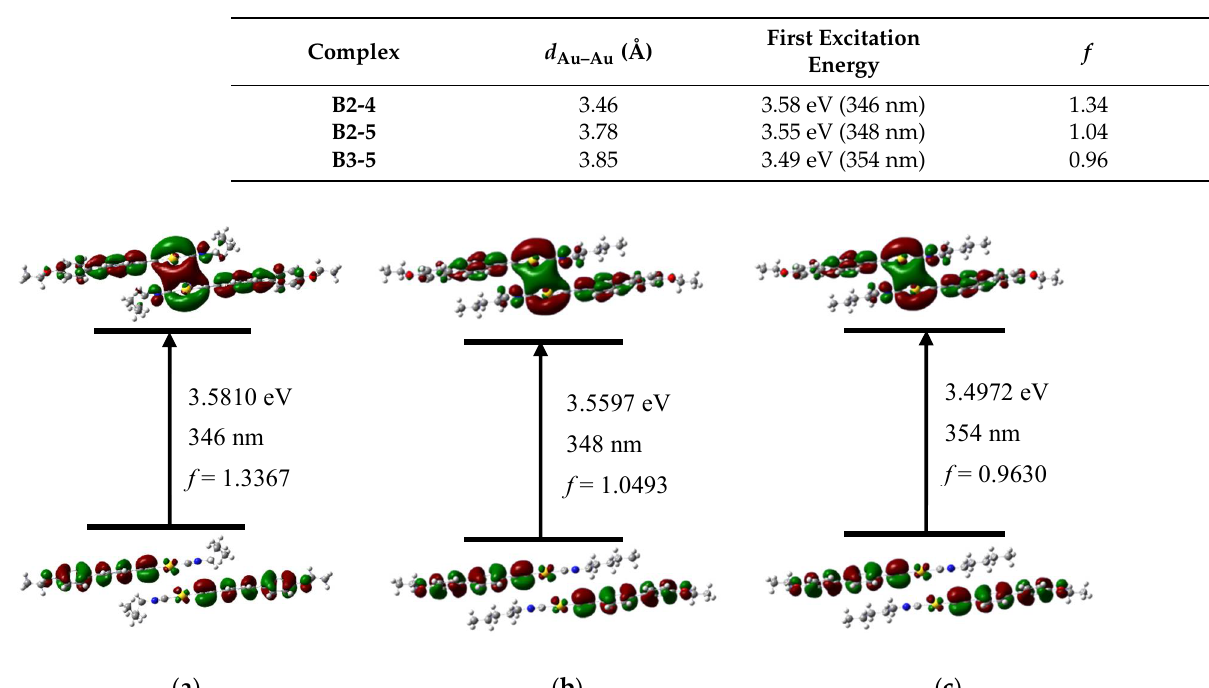
Figure 6. Photoluminescence spectra of B3-5 ( λ ex = 352 nm) in various phases obtained from ( a ) heating the crystal and ( b ) freezing the molten states. Inset: magnification of emission spectra during the freezing process. Green, Cr; blue, N; orange, I. Table 4. TD-DFT results for all gold complexes.